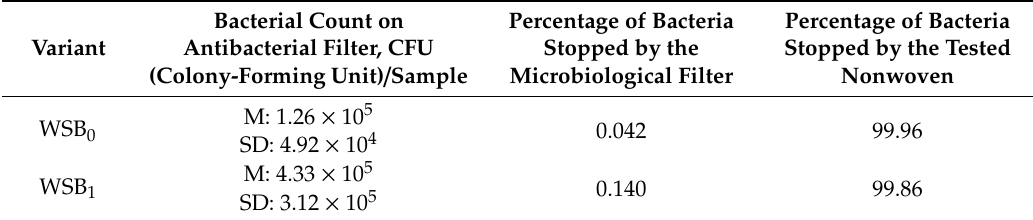
Table 6. Filtration performance of the filtering nonwovens WSB 0 and WSB 1 against S. aureus aerosol. Bacterial Count on Variant Antibacterial Filter, CFU (Colony-Forming Unit) / Sample